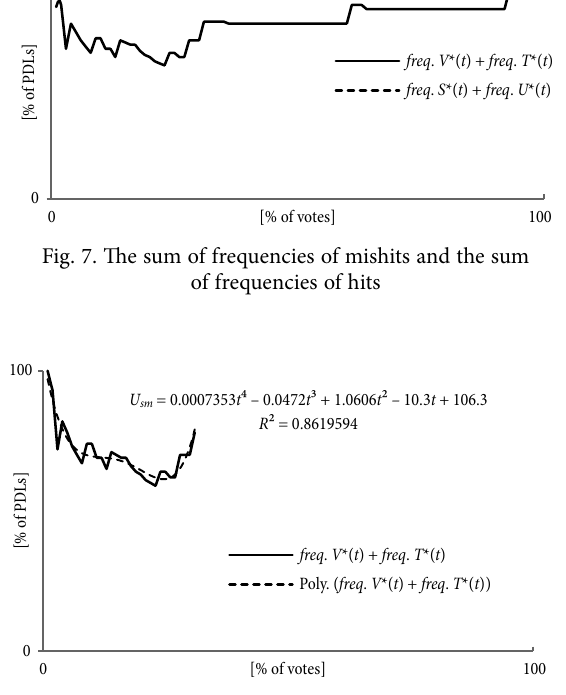
Fig. 8. Optimisation using the minimization of the sum of frequencies of